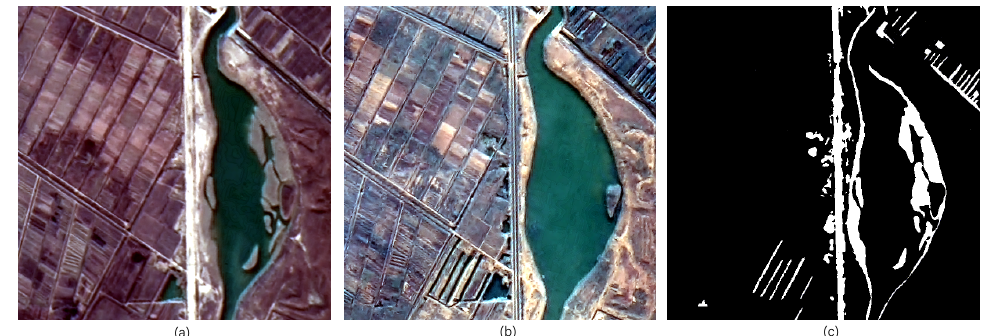
Figure 4. Multispectral images and reference image of Hongqi Cancal dataset. ( a ) Image acquired on 9 December 2013. ( b ) Image acquired on 16 October 2015. ( c ) Reference image.